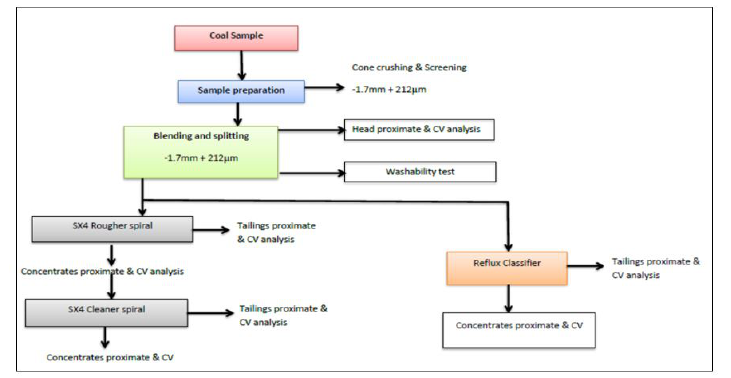
Figure 1. Flowsheetfor work conducted